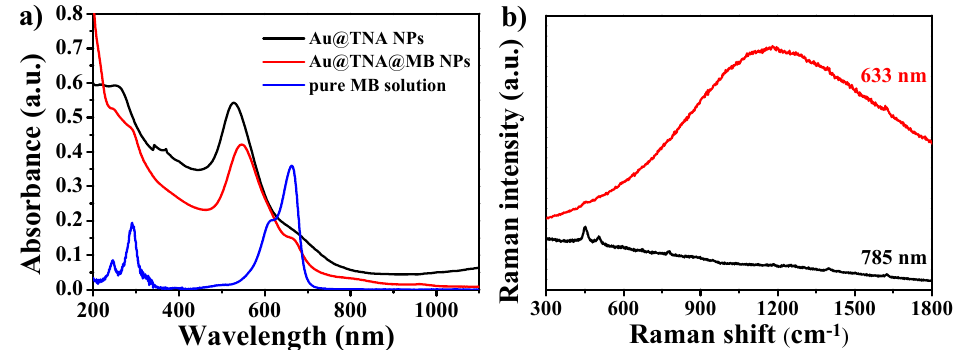
Figure 2. ( a ) UV-visible and ( b ) fluorescence spectra of Au@TNA NPs, Au@TNA@MB NPs, and methylene blue (MB) molecules. ( b ) SERS measurement of Au@TNA@MB NPs at 633 and 785 nm.